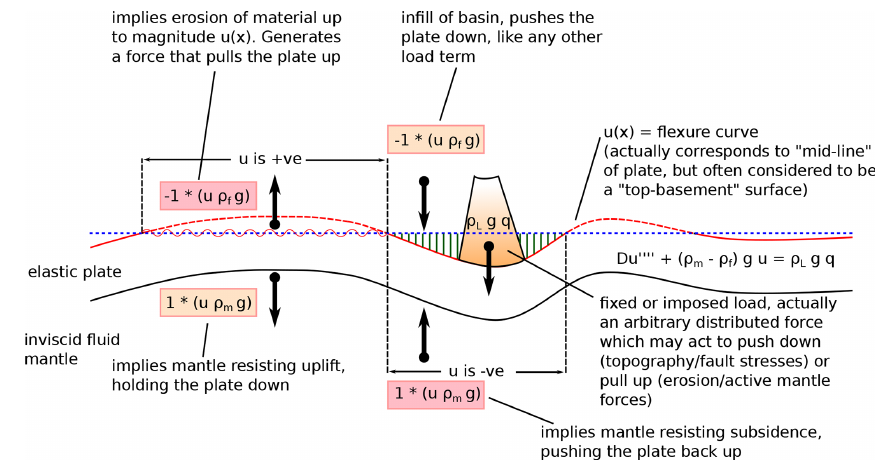
Figure 2. Flexure equation and its physical significance. “Restoring” forces (constant multiplied by the plate vertical deflection, u(x) ) have differing effects according to whether u(x) is positive when there is, by default, erosion of the plate to level zero; when negative, there may be infill of basins created by flexural subsidence. Mantle forces are always present and damp subsidence due to surface loading but equally damp uplift when flexure bends things above zero reference level.